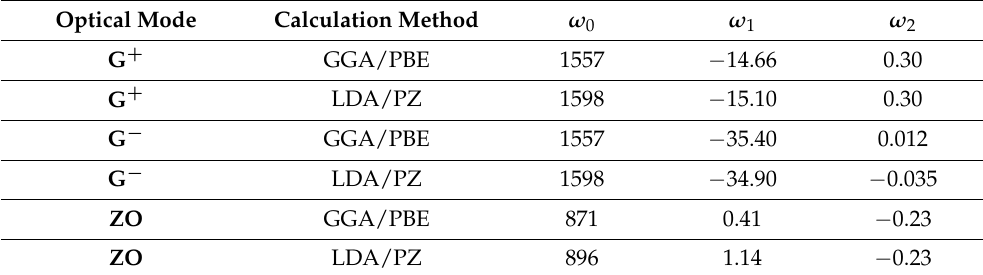
Table 6. Zero strain values ω 0 (in cm − 1 ), and coefficients ω 1 [in cm − 1 /(%strain)] and ω 2 [in cm − 1 /(%strain) 2 ] of the strain dependence [see Equation (3)] of the optical in-plane (G + and G − ) and out-of-plain ZO phonons at the Γ point, when the strain is applied along the zigzag direction, as obtained by DFT